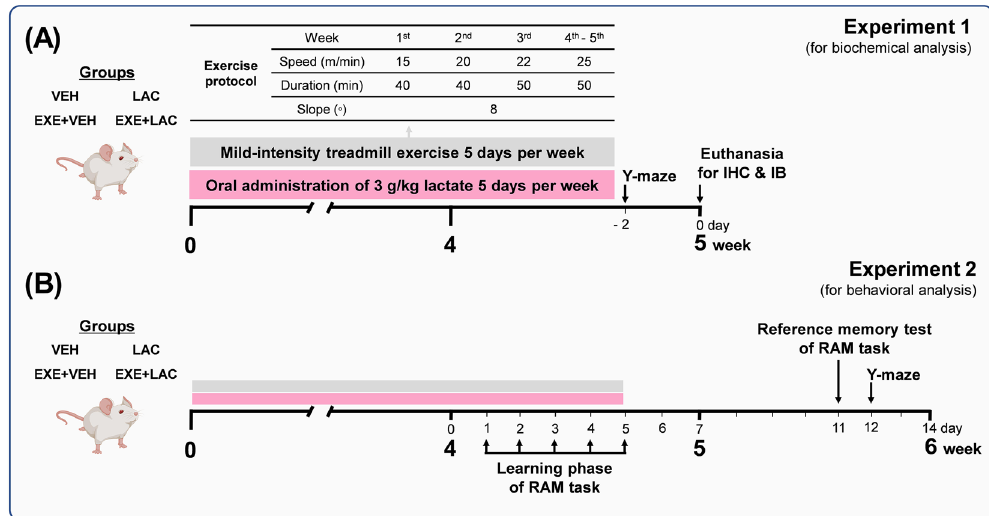
Figure 2. The schematic representation of experimental procedure. The experiments started with 7-week-old male ICR mice. In case of EXE + LAC, mice were administrated lactate immediately after exercise. This study comprised two independent experiments except the pilot test: ( A ) one mainly for biochemical analysis ( n = 9 per group) and ( B ) the other for behavioral analysis ( n = 8 per group). VEH sedentary without lactate, LAC sedentary with lactate, EXE + VEH exercise training without lactate, EXE + LAC exercise training with lactate, IHC immunohistochemistry, IB immunoblotting, RAM radial arm maze. The mouse icon is “Created with